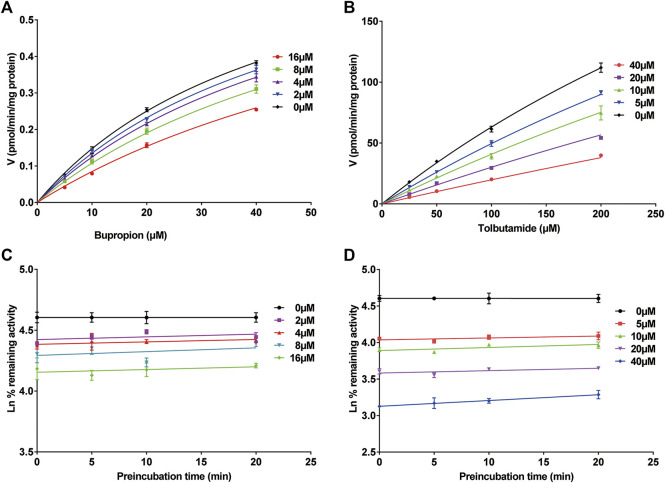
Michaelis-Menten saturation curves of (A) bupropion and (B) tolbutamide. Time- and concentration-dependent inhibition of poziotinib on rat liver microsome. Incubation reaction mixtures were pre-incubated for 0, 5, 10 and 20 min without or with poziotinib at 2, 4, 8 and 16 µM for bupropion (C) or 5, 10, 20, 40 µM for tolbutamide (D). All data were mean ± SD of triplicate determinations.